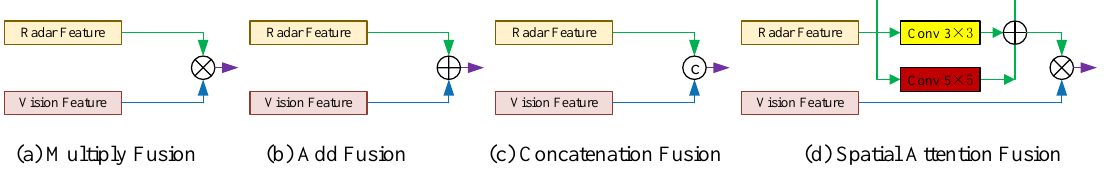
Figure 7. Different fusion blocks in feature fusion scheme. From the left to right: Multiply Fusion (MUL) Block, Element-Wise Add Fusion (ADD) Block, Concatenation Fusion (CAT) Block and Spatial Attention Fusion (SAF)